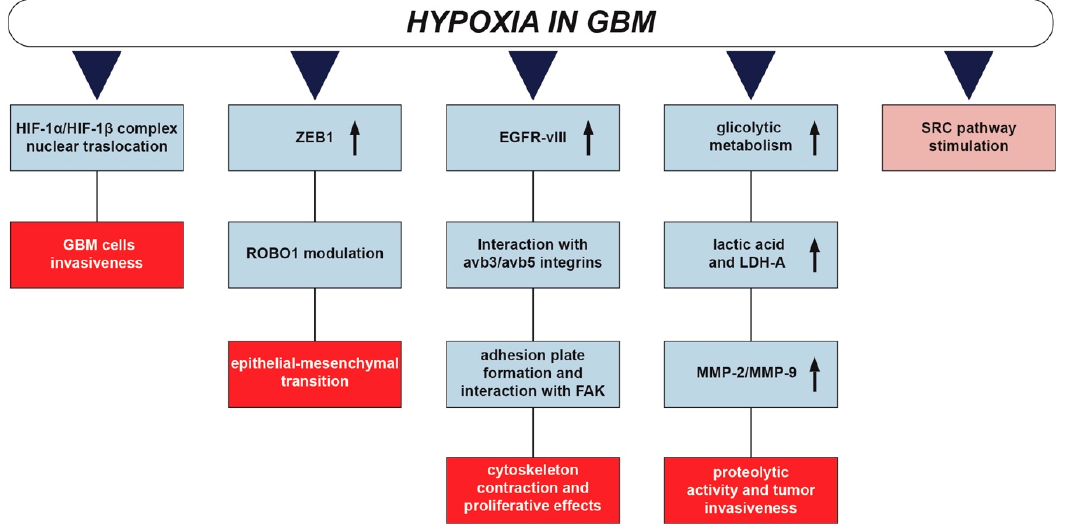
Figure 3. Schematic representation of the main pathways for the invasion process induced by hypoxia. SRC pathway stimulation under hypoxia contributes to the deregulation of the principal events required for invasion, including cell adhesion, activation of cell motility, and production of proteolytic